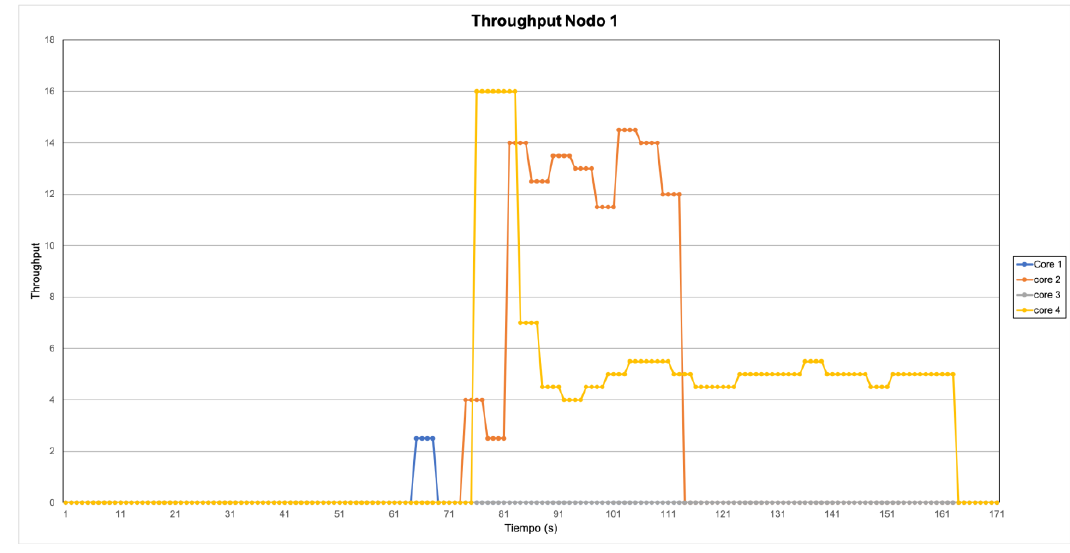
Figure 15. RPI node 1 power consumption.